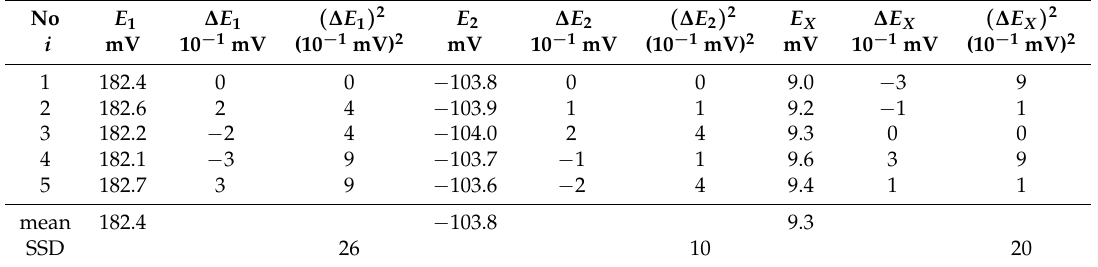
Table 1. Potential indications of pH-meter during calibration and